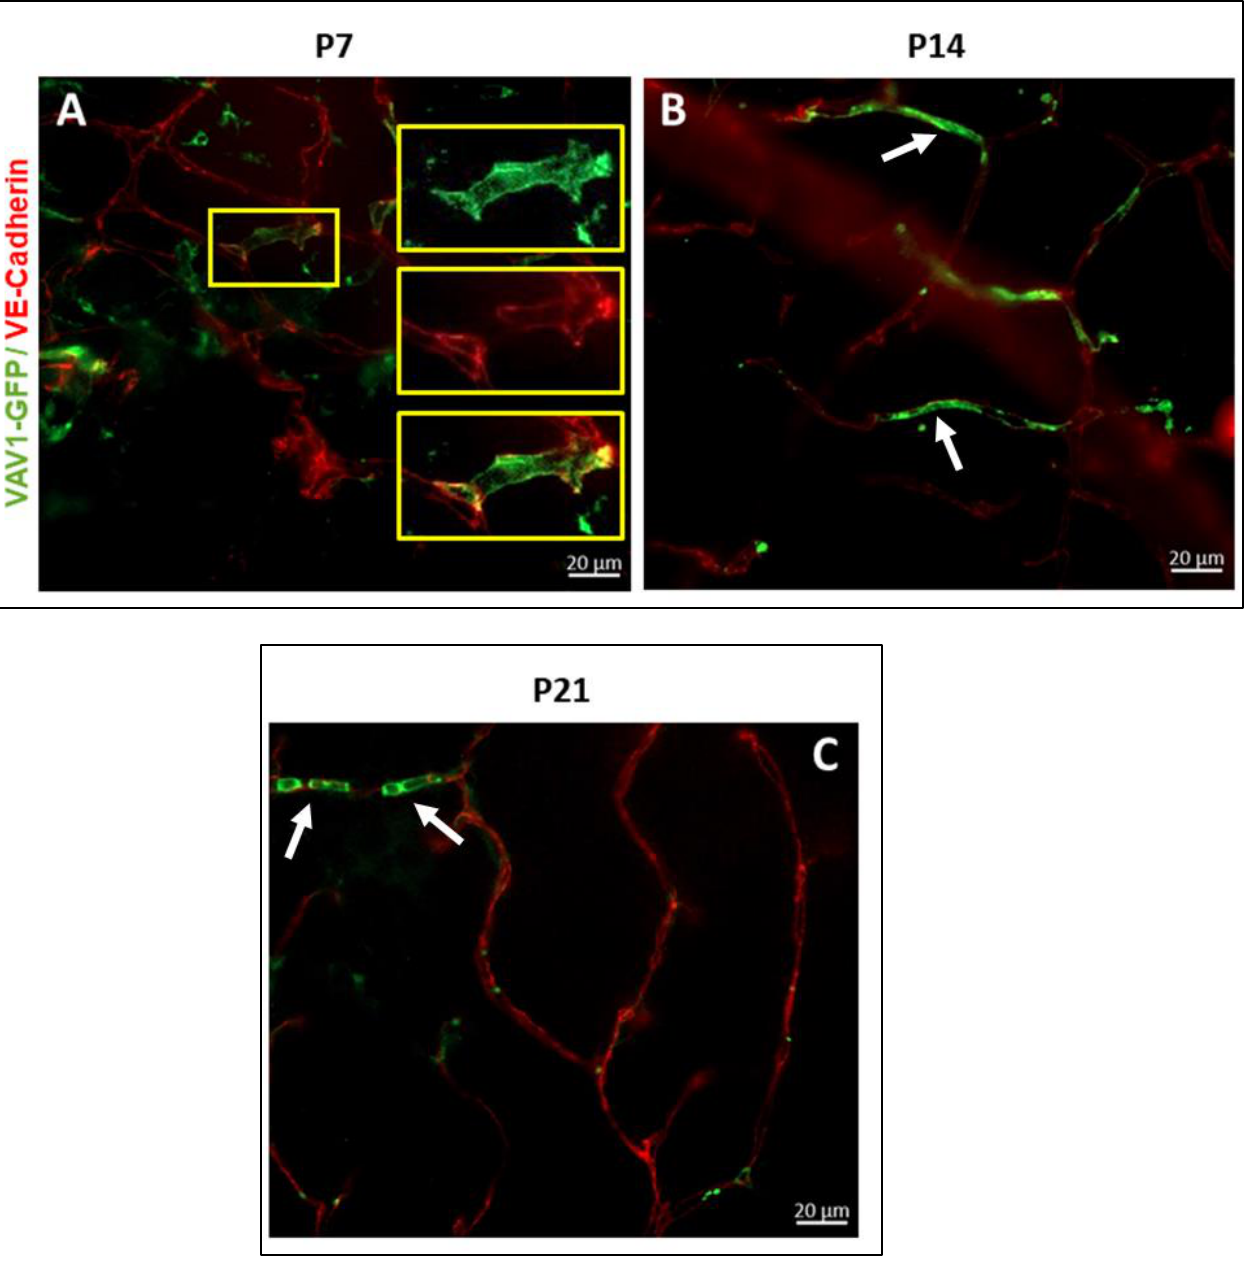
Figure 4. Hematopoietic cells in retinal vascular development. Hematopoietic cells support angio- genesis in the developing retina. GFP + hematopoietic cells provide a framework for the completion of a branch vessel in the retina at P7 (( A ), inset) and are occasionally incorporated into the develop- ing vasculature at P14 (( B ), white arrow) and P21 (( C ), white arrow) for the formation of healthy/nor- mal vessels.